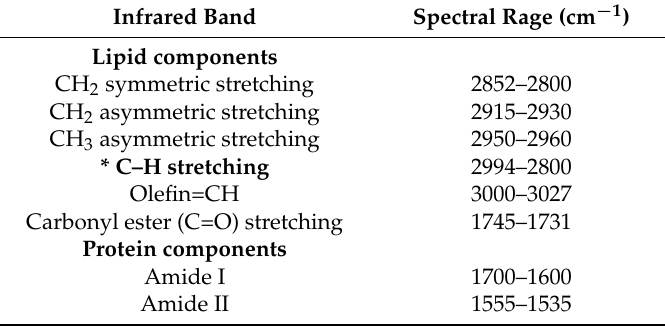
Table 1. The spectral regions used for the analytical